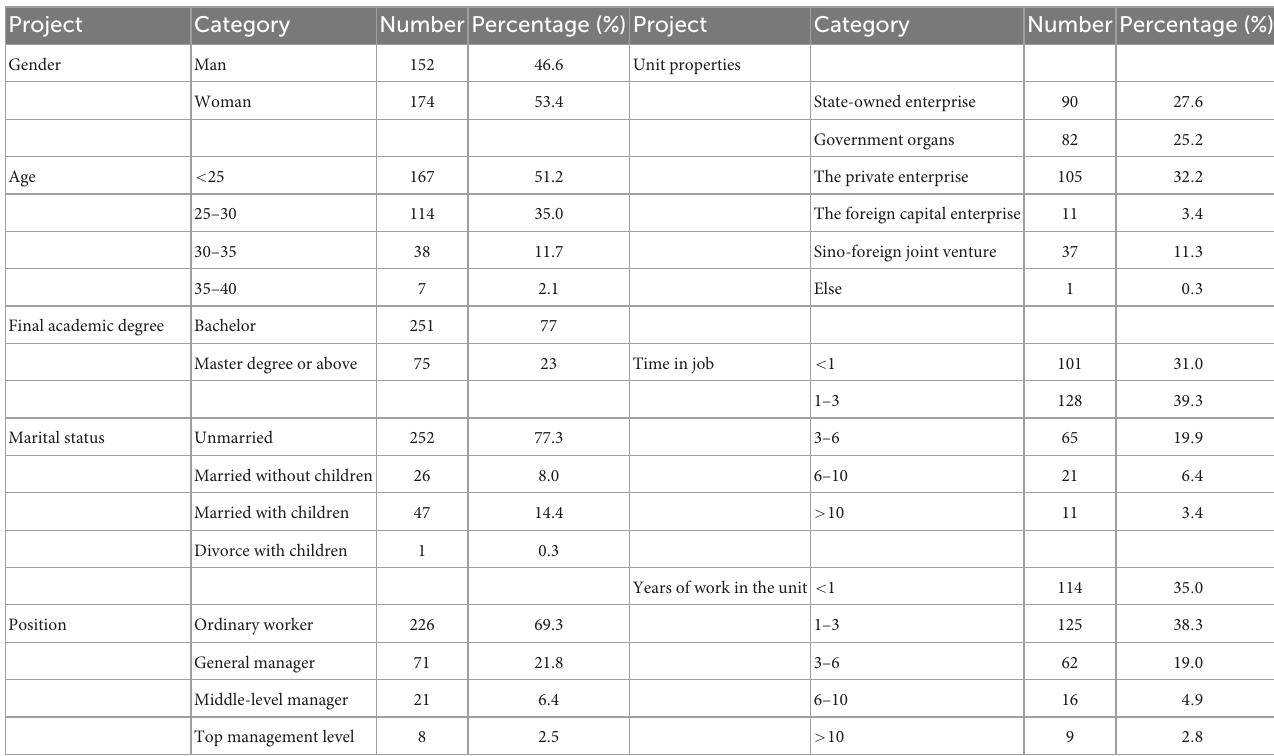
TABLE 1 Basic information of respondents ( N =